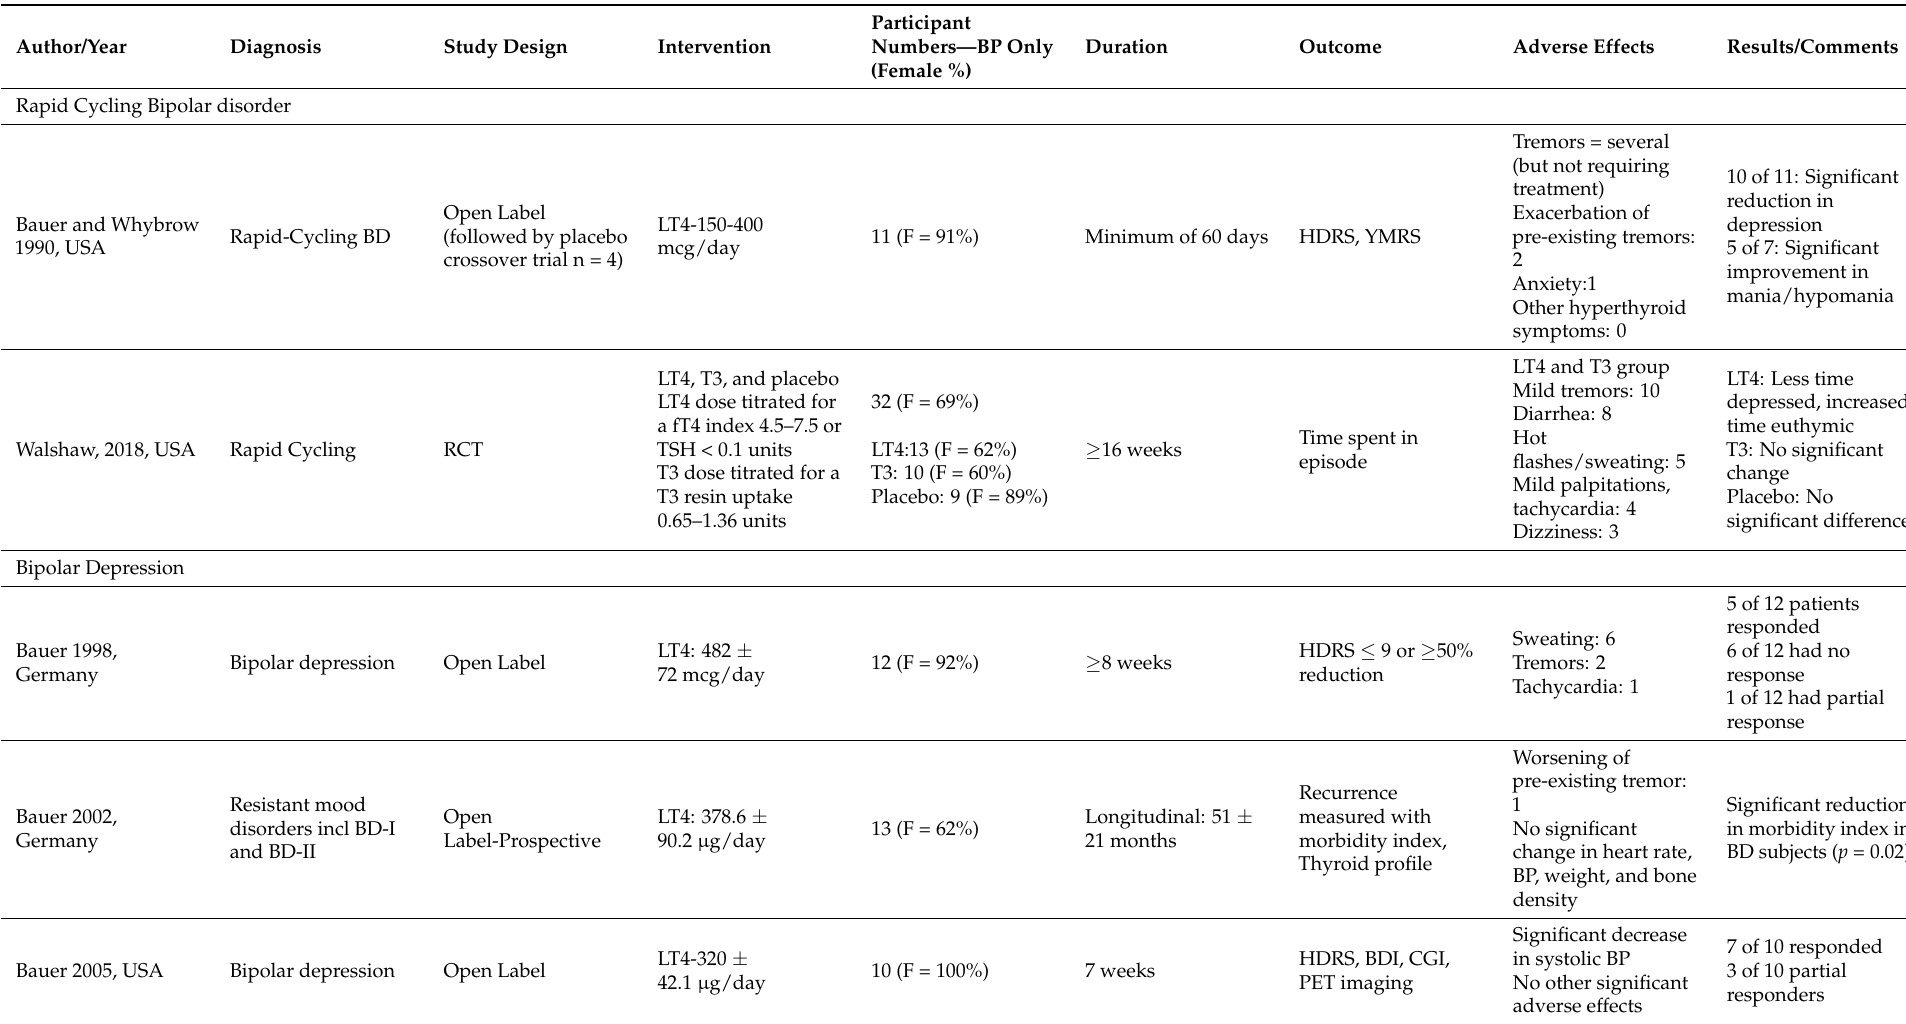
Table 1. Characteristics of the included